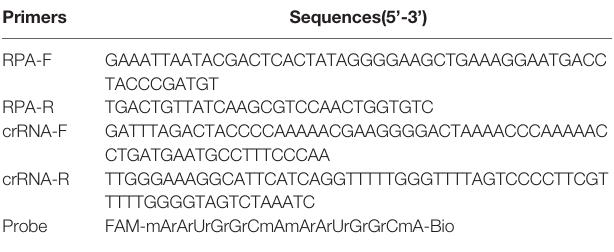
TABLE 1 | The crRNA, primers, and probes used in this